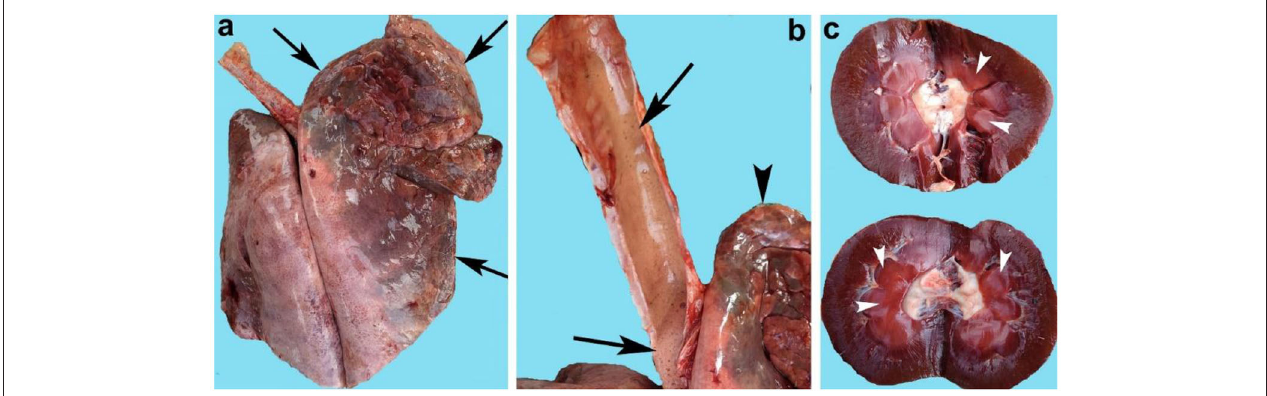
FIGURE 1 | Organs of goats that died of enterotoxemia showing (a) congested and consolidated lungs (arrows), (b) trachea full of froth (arrows) along with congested lungs (arrowhead), and (c) congested kidneys (arrowheads).